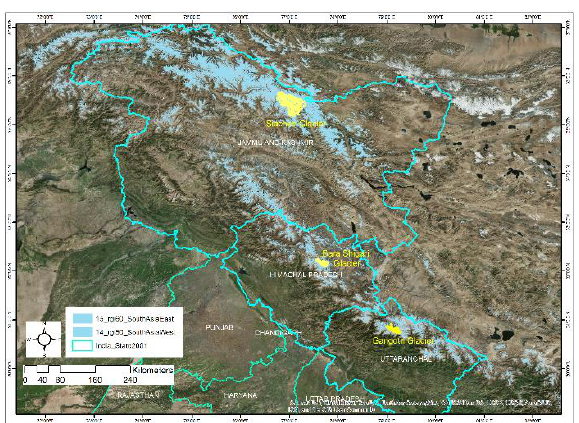
Figure 2: Selected glaciers (Siachen, Gangotri and Bara Shigari) for glacier dynamics study in NWH region (The background RS data is from Digital Globe and